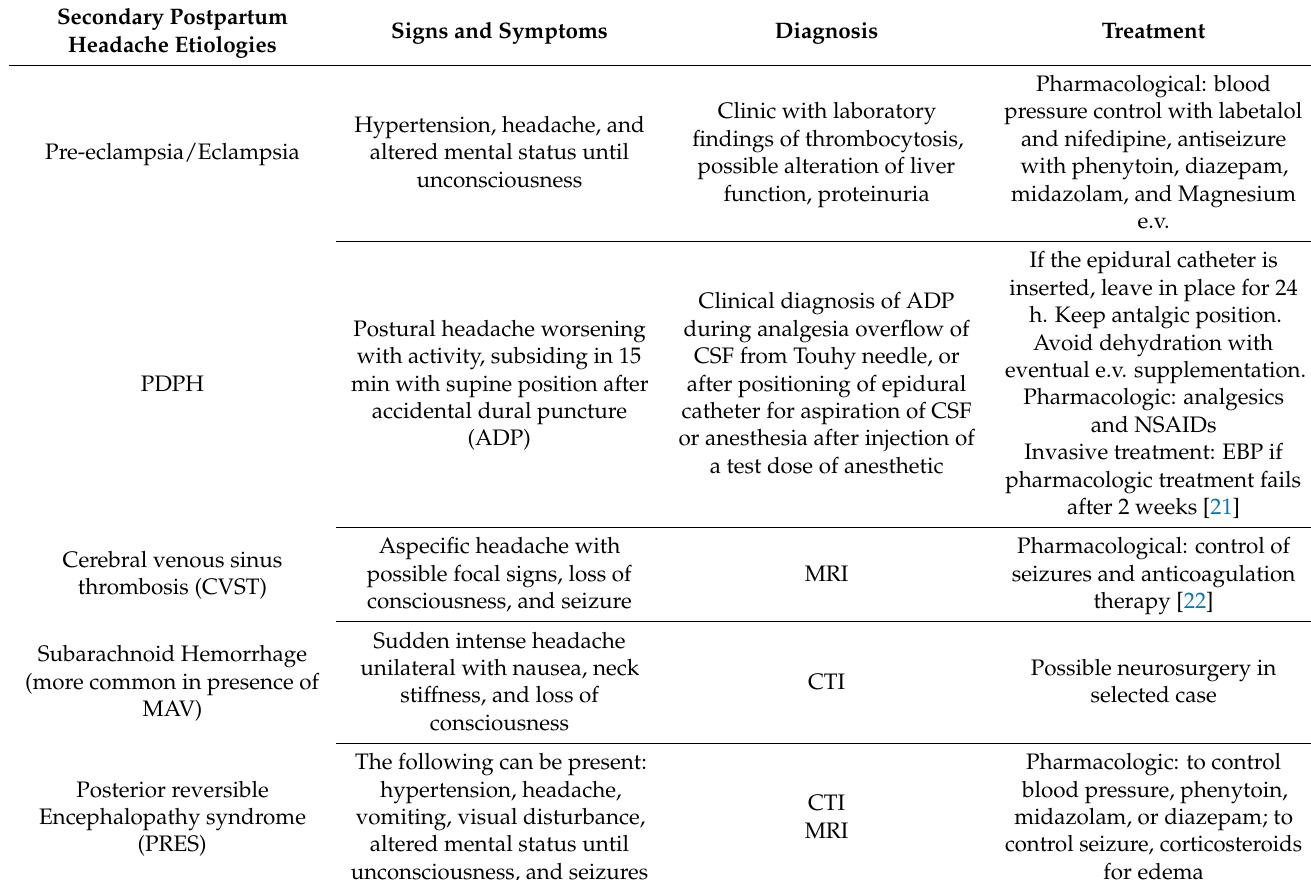
Table 1. The differential causes of secondary postpartum headache, helpful elements for diagnosis, and common manage- ment. CSF: cerebral spinal fluid; EBP: epidural blood patch; NSAIDs: non-steroidal anti-inflammatory drugs; MRI: magnetic resonance imaging; CTI: computed tomography imaging